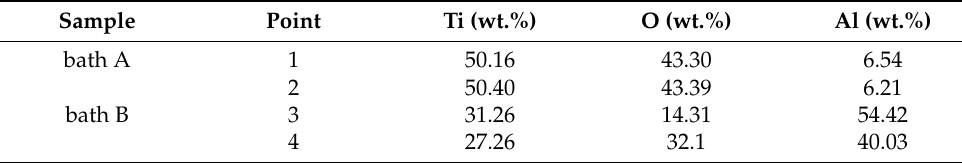
Table 1. EDS results of the PEO-treated Cp-Ti in two different aluminate concentrations: low concentration (bath A) and high concentration (bath B). Points for analysis are taken from the surface area shown in Figure